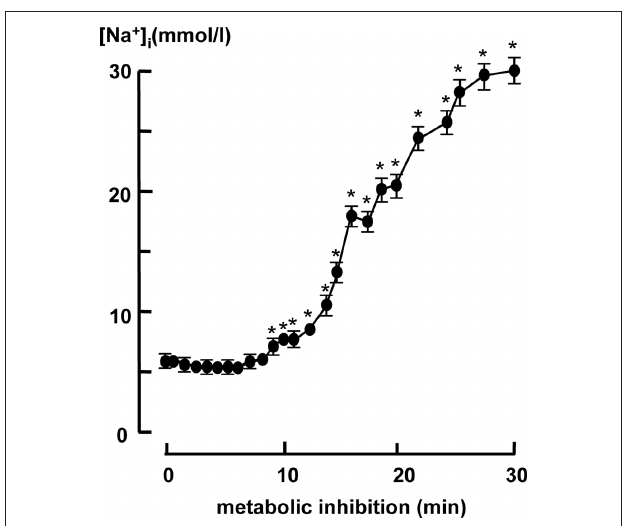
FiguRe 1 | Cytosolic [Na + ] in 2 Hz stimulated myocytes ( n = 20) during i metabolic inhibition. All data expressed as mean ± SEM. * p < 0.05 versus Ctrl ( t = 0; one way